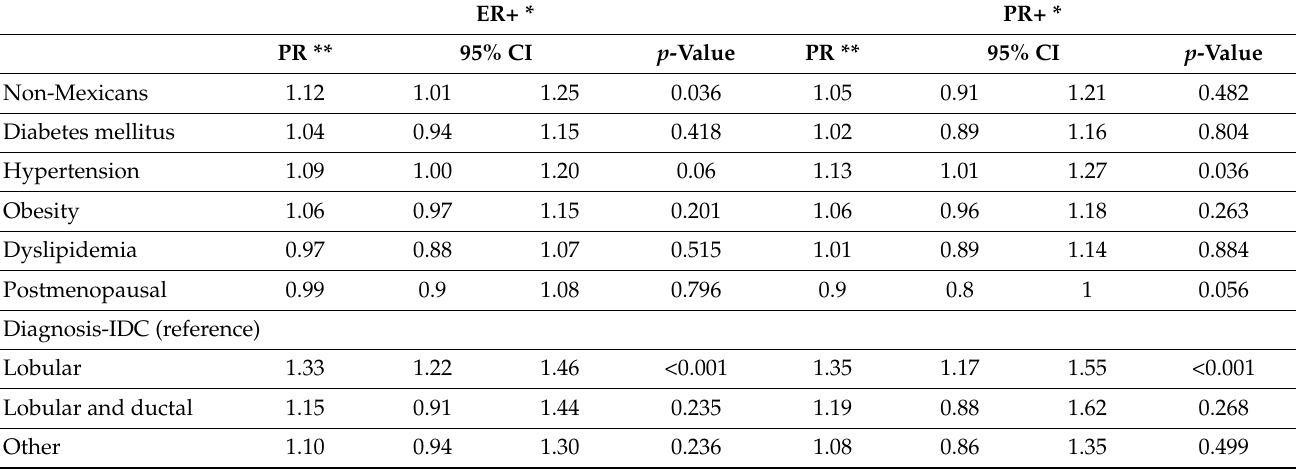
Table 2. Association of Hispanic origin with breast cancer subtypes (ER, PR, HR, and triple